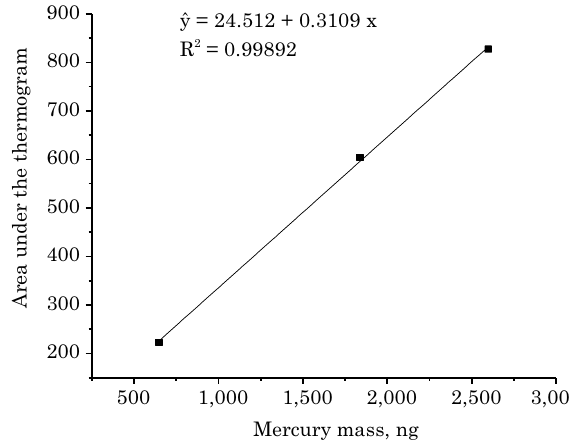
figure 4. curve of the area under the thermogram as a function of mercury mass from certified reference material Montana Soil nist-SrM 2711 (6.25 ± 0.19 μg g -1 of